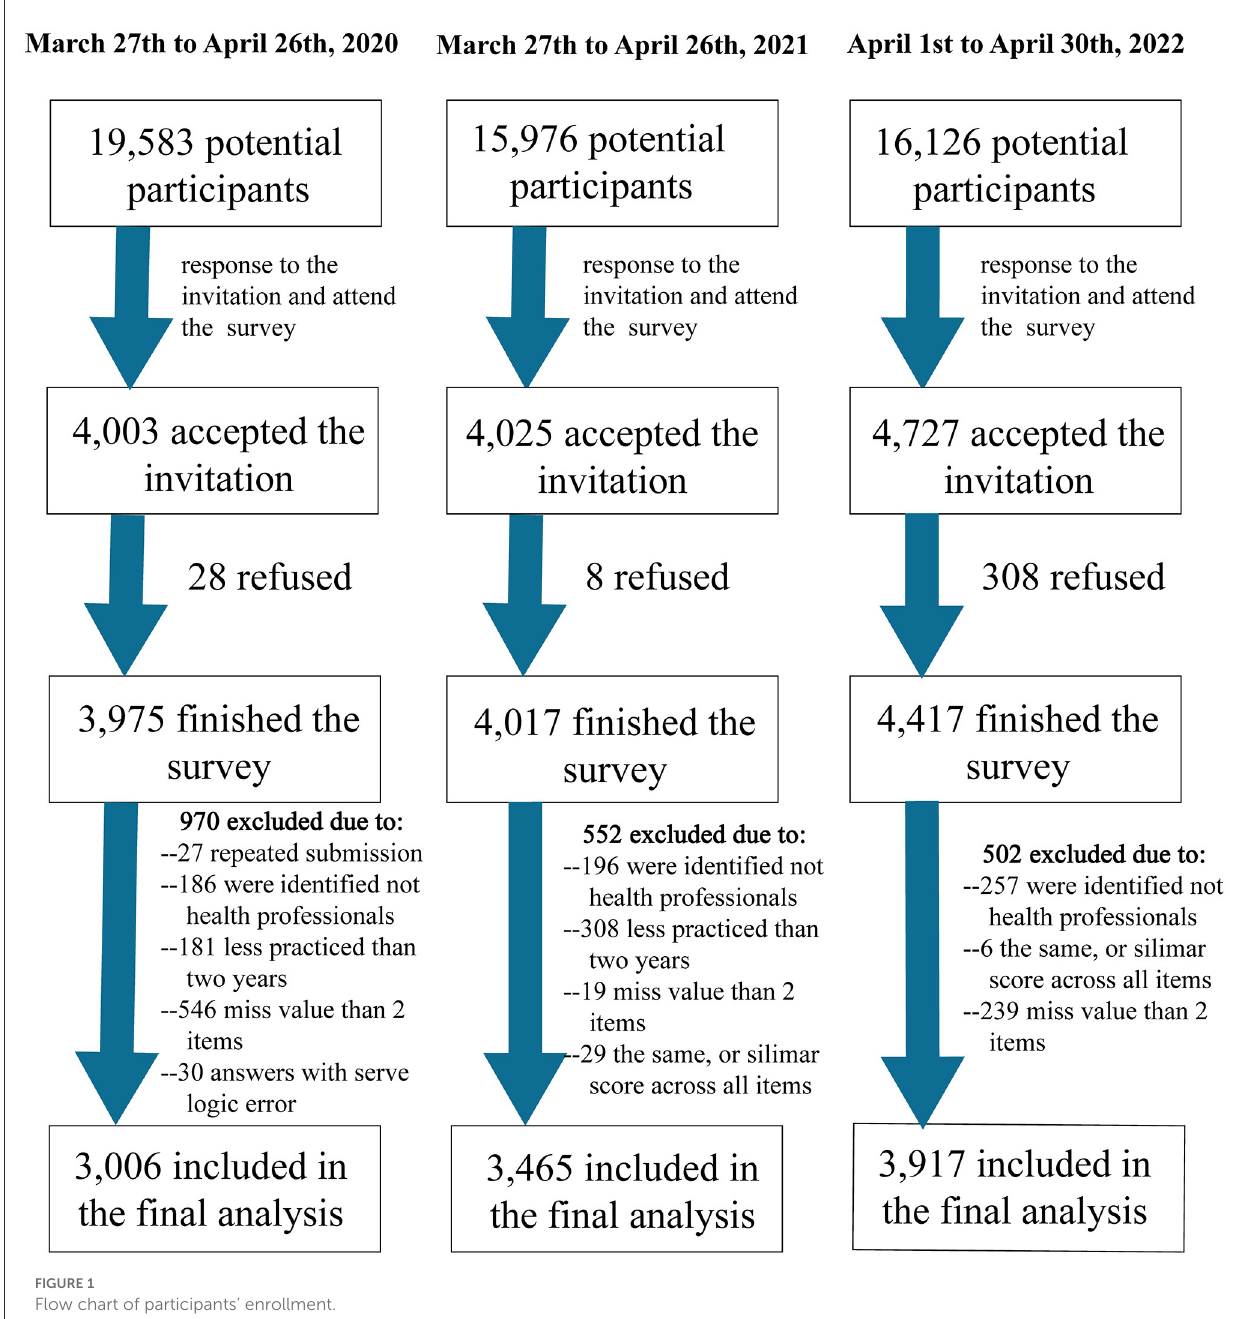
FIGURE1 Flow chart of participants’